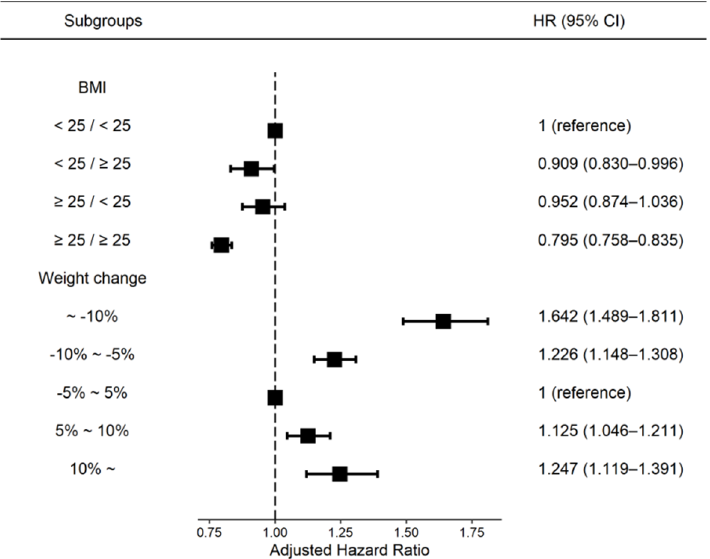
Figure 3. Incidence rates and hazard ratios of ESRD according to the BMI and weight changes. Adjusted for age and sex, smoking, alcohol consumption, regular exercise, low-income status, use of insulin, number of oral hypoglycemic agents, diabetes duration, and previous histories of hyperten- sion, dyslipidemia, and baseline body weight. BMI, body mass index; WC, waist circumference; HR, hazard ratio; CI, confidential interval.